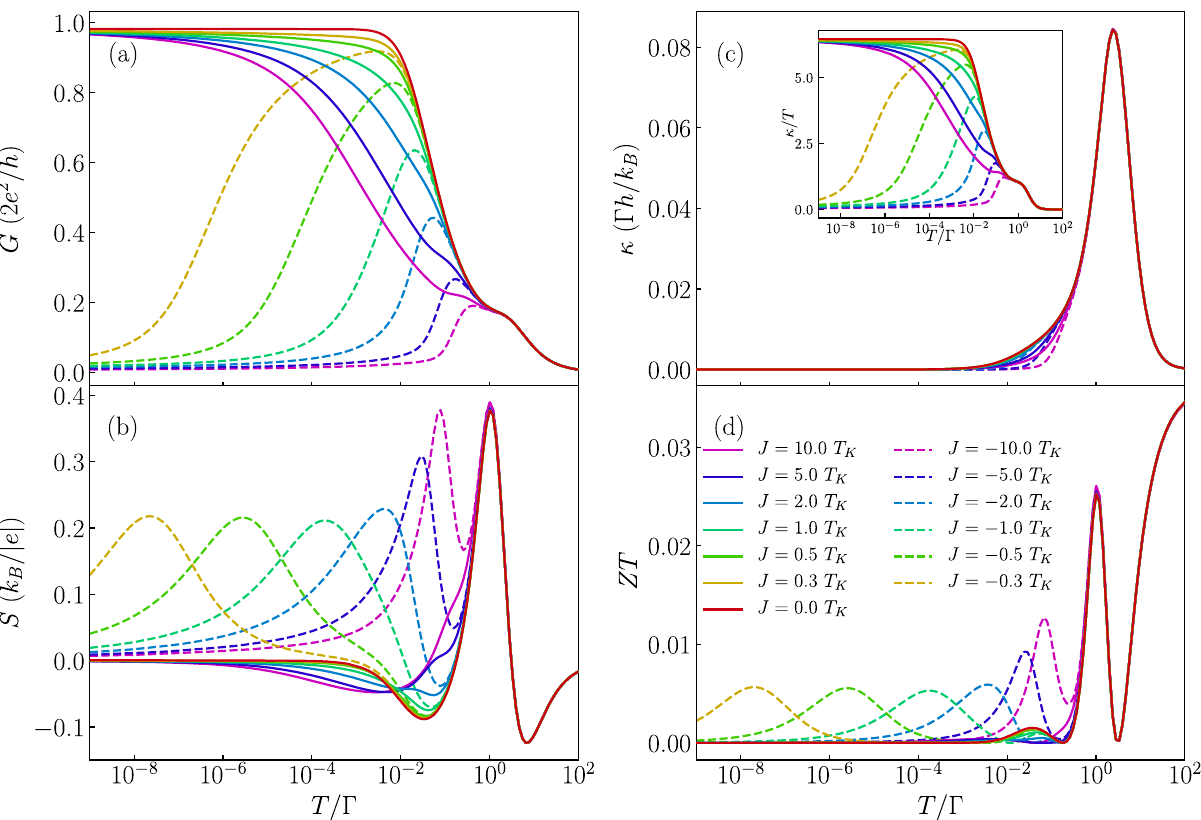
Figure 3. Dependence of thermoelectric coefficients on exchange interaction. ( a ) The conductance, ( b ) Seebeck coefficient, ( c ) heat conductance and ( d ) figure of merit as a function of temperature for selected values of exchange interaction J in the case of nonmagnetic contacts. The solid (dashed) lines correspond to the case of ferromagnetic (antiferromagnetic) exchange interaction. The inset in ( c ) presents the temperature dependence of κ/ T . The parameters are the same as in Fig. 2 with ε = − U / 3